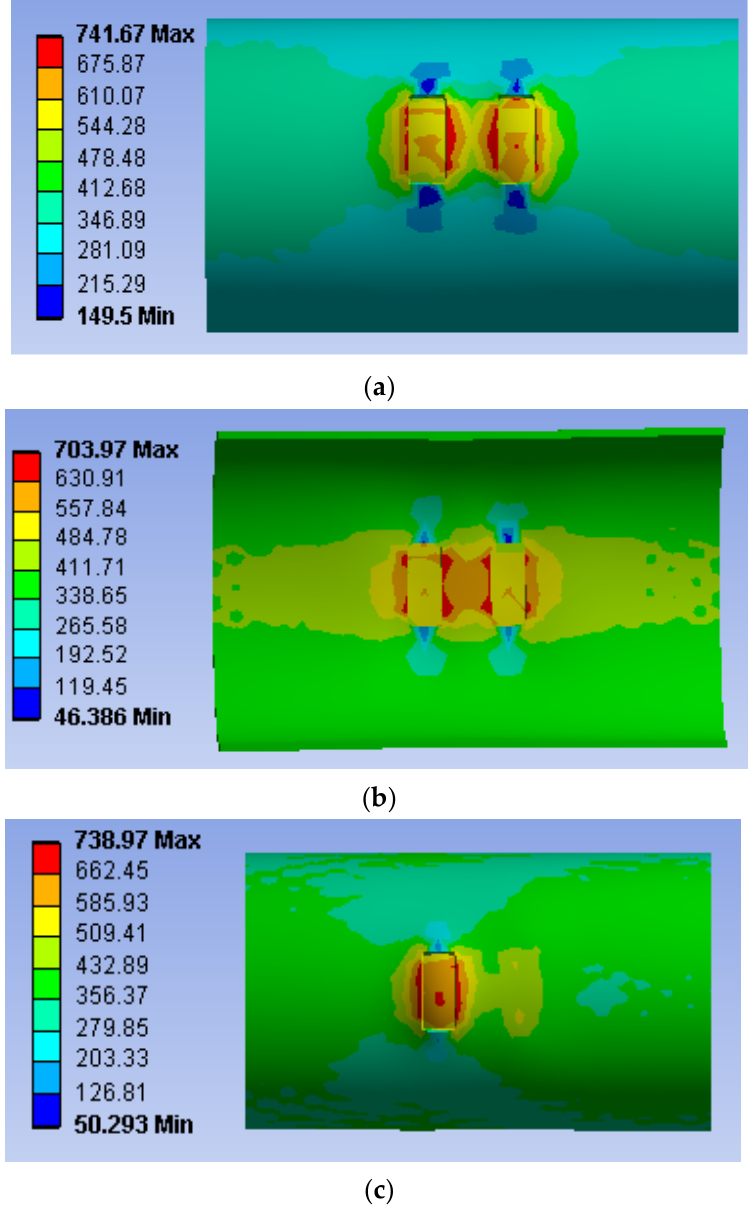
Figure 4. Stress nephogram of different double defect pipe models: ( a ) the exterior wall; ( b ) the interior wall; ( c ) the interior and exterior wall.